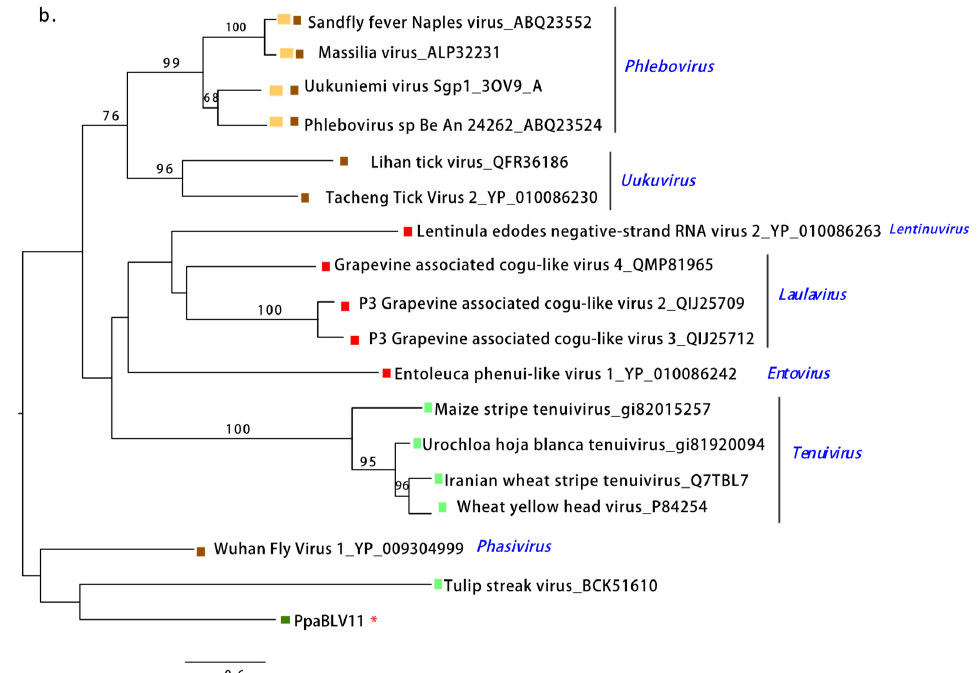
Figure 2. ( a ) Maximum likelihood tree (RAxML) depicting the phylogenic relationship of the pre- dicted RdRP of Phytophthora palustris bunya-like viruses with other complete RdRP belonging to related viruses from the order Bunyavirales . ( b ) RAxML tree with the NC of PpaBLV11 and other bunyaviruses of the family Phenuiviridae . Nodes are labeled with bootstrap support values ≥ 50%. Branch lengths are scaled to the expected underlying number of amino acid substitutions per site. Phytophthora palustris bunya-like viruses 1–13 (and variants) are represented by their abbreviated names (PpaBLV1-13) and indicated with a red asterisk (*). Family classification and the correspond- ing GenBank accession numbers are shown next to the virus names. Colorful squares represent the virus host kingdom or phylum: Fungi, Nematoda, Oomycota, Arthropoda, Plants, Mammalia, (Fishes) Chordata, Ochrophyta (Heterokonta), Excavata. Scale bars repre- sent expected changes per site per branch.